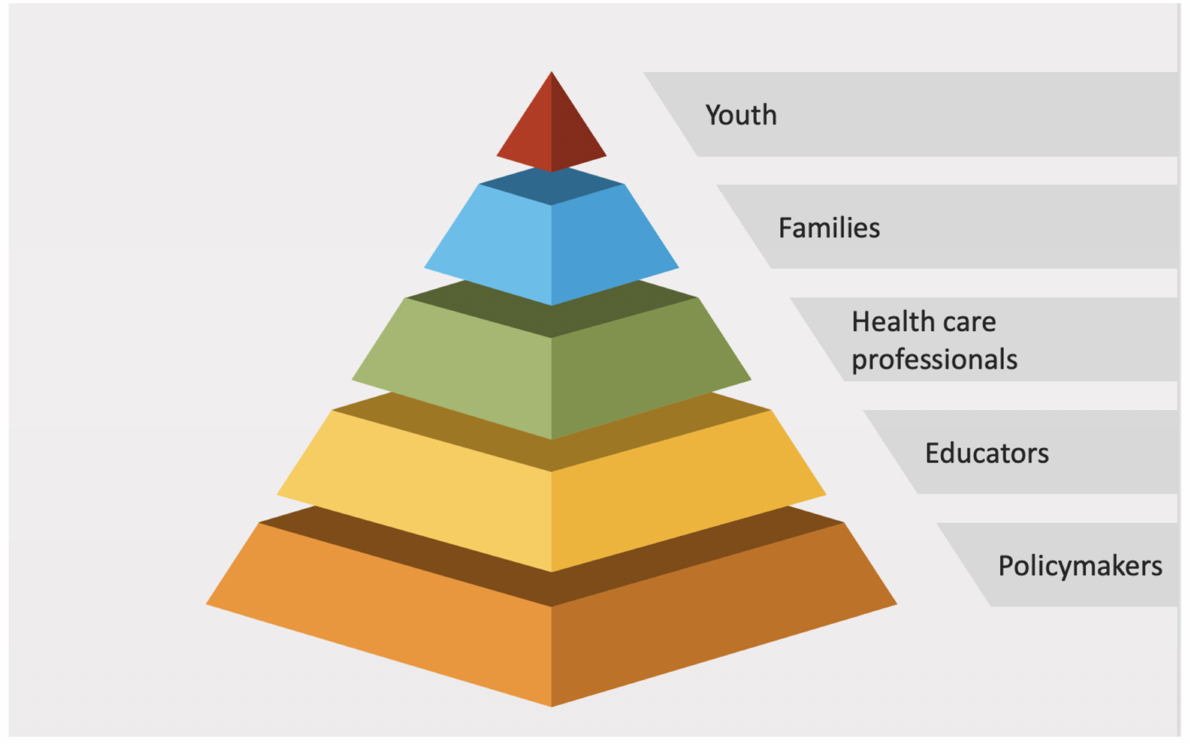
Figure 1. The five factor